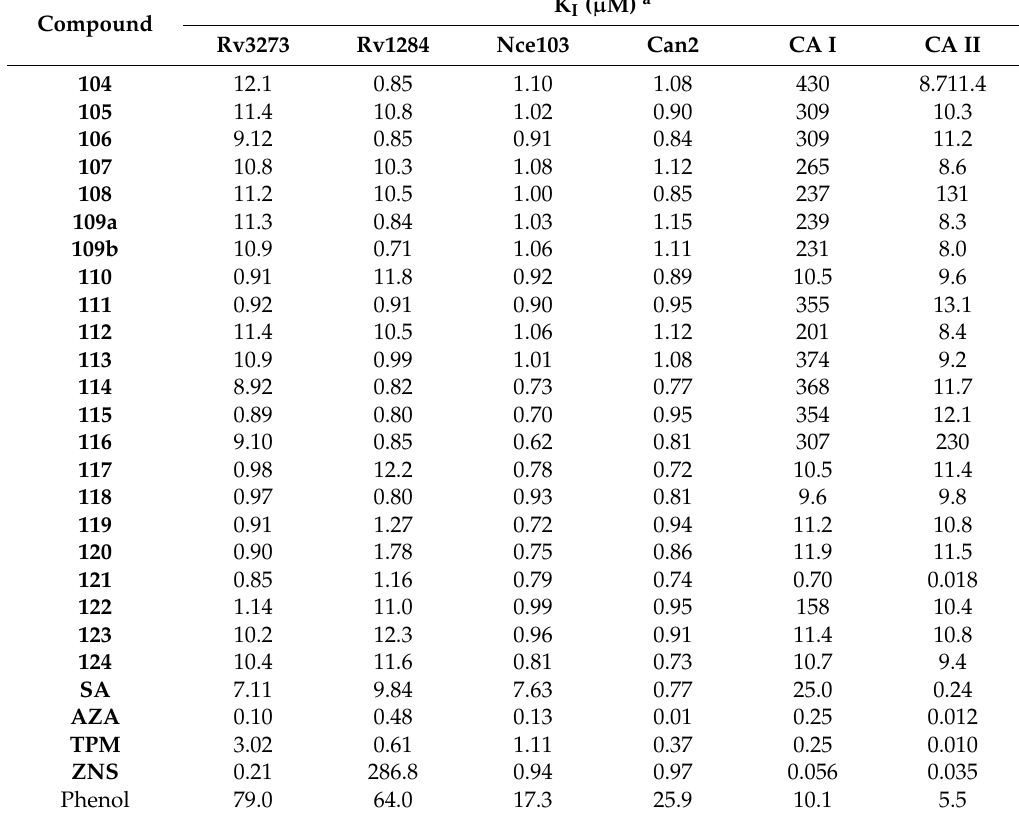
Table 12. Enzyme inhibition of pathogenic M. tuberculosis β -CA isozymes Rv3273 and